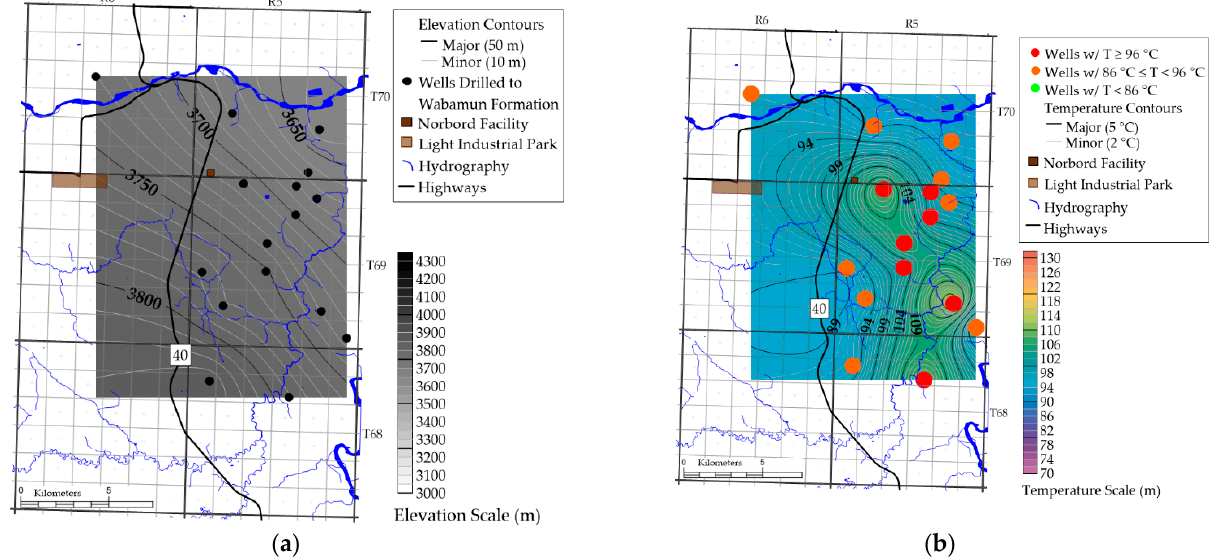
Figure 6. Contour maps of the study area for the Precambrian Basement showing ( a ) depth to the top and ( b ) temperature at the top.